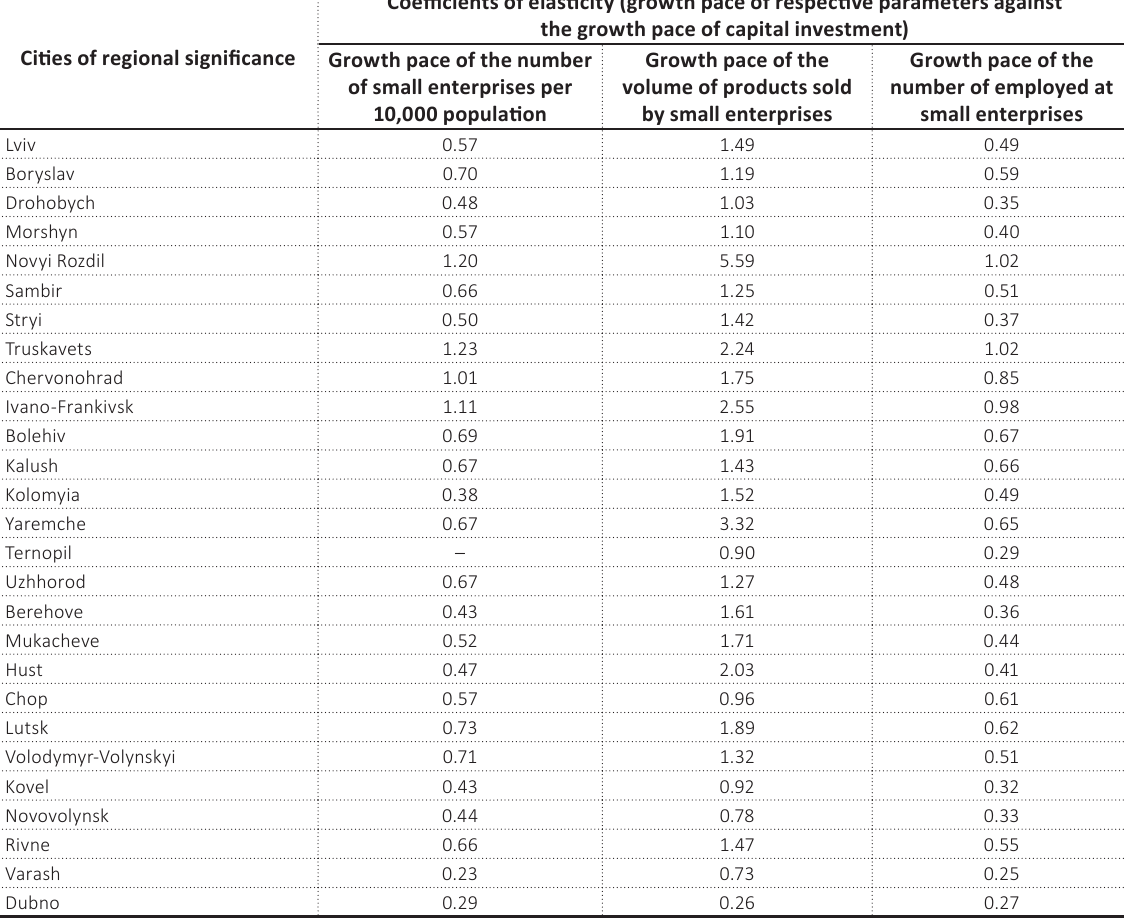
Table 4. Evaluation of the impact of investment processes on structural transformations in small businesses in cities of regional significance in the Western region of Ukraine* Coefficients of elasticity (growth pace of respective parameters against the growth pace of capital investment) Cities of regional significance Growth pace of the